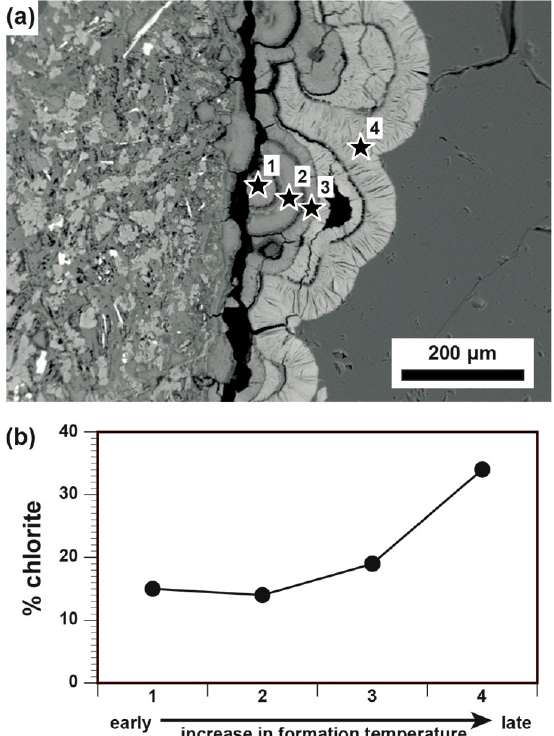
Figure 7. ( a ) Back-scattered electron image showing prograde formation of mafic clay minerals within a vesicle of a basaltic lava flow in the Hvalfjördur area, SW Iceland. ( b ) Chlorite content of the interstratified chlorite / smectite minerals coating the vesicle wall. Numbers correspond to the stars in ( a ). Data based on Weisenberger and Selbekk [7].